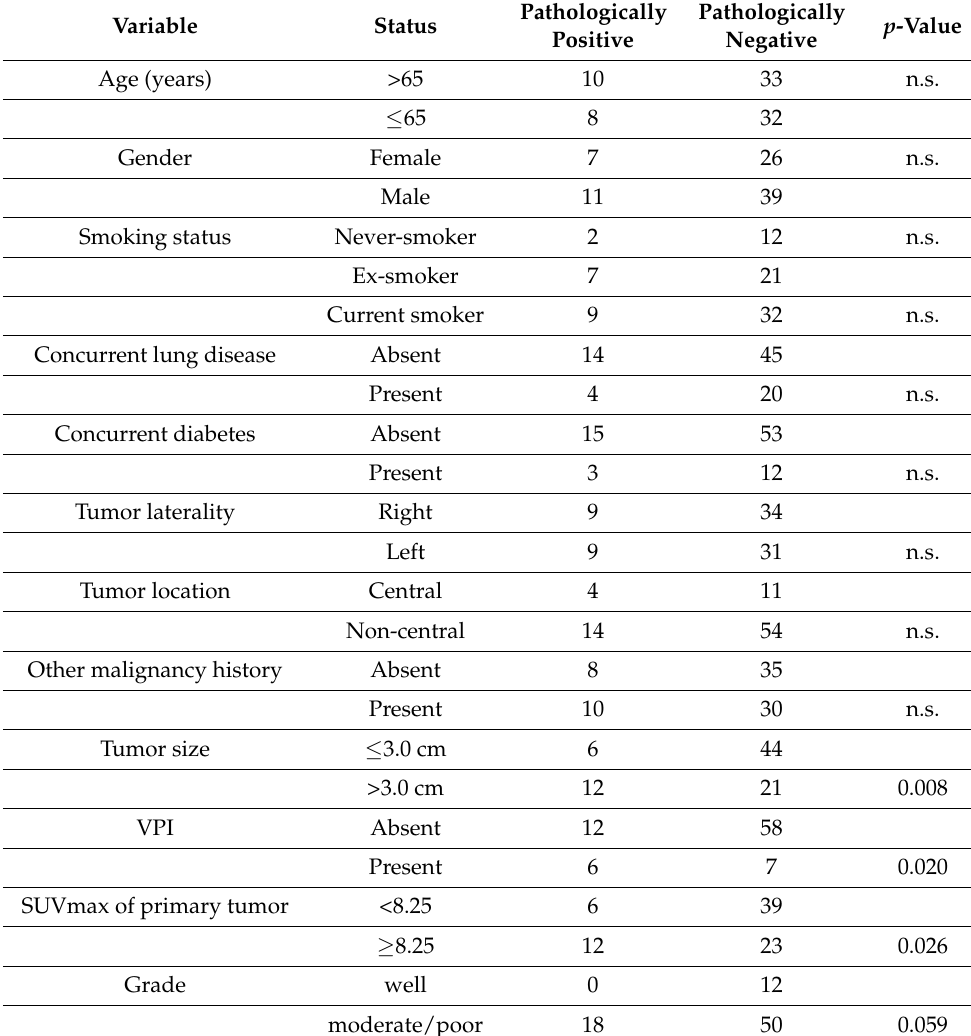
Table 4. Univariate analysis for factors associated with false negatives in integrated 18F-FDG-PET/CT negative